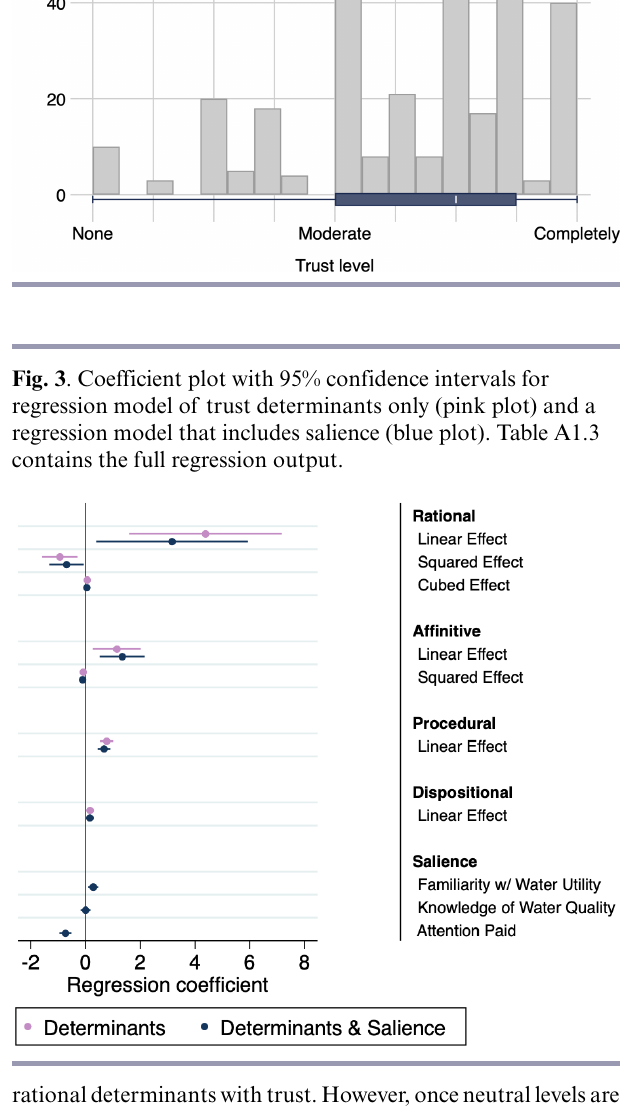
procedural (C), and dispositional (D) determinants of trust and expected overall trust holding other determinants constant at their averages. Random noise was added to the scatterplot to perturb the location of markers of overlapping data and provide greater information about the number of observations at each